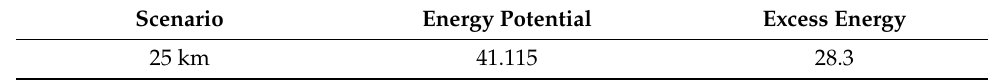
Table 3. UAE’s results for CSP energy potential and excess energy in GWh/km 2